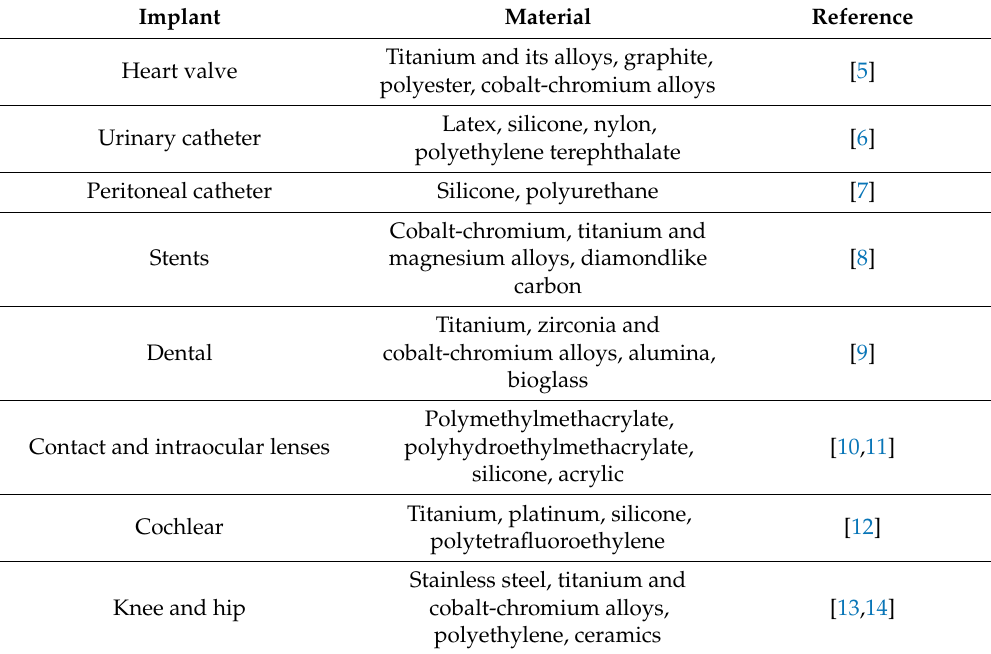
Table 1. Summary of some of the main biomedical devices and materials used in